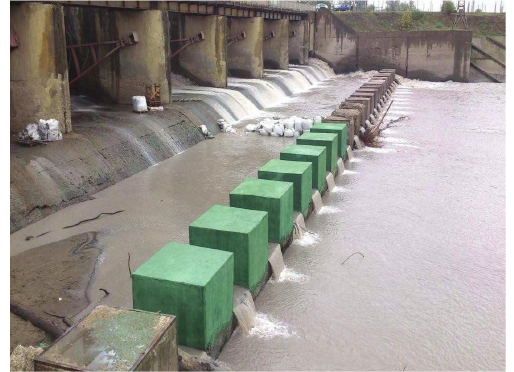
Figure 1: The ice-protection devices of the Belorechinskaya dam have been coated by the EpoxyPAN after 3 years of exploitation (green color).